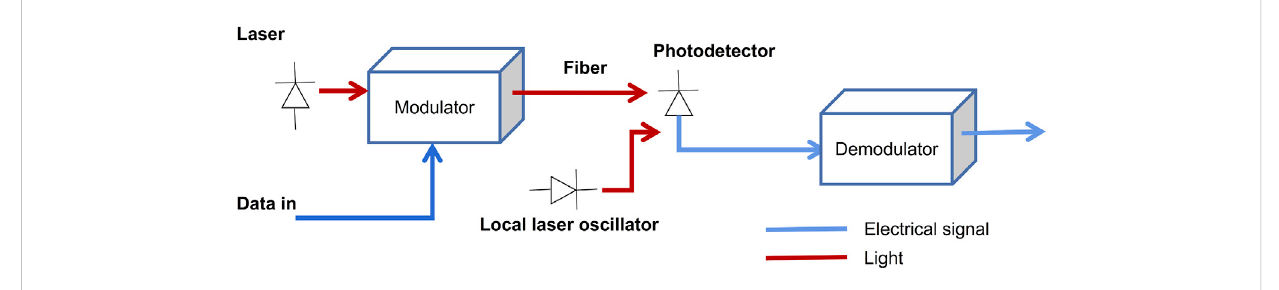
FIGURE 1 Spatially coherent communication